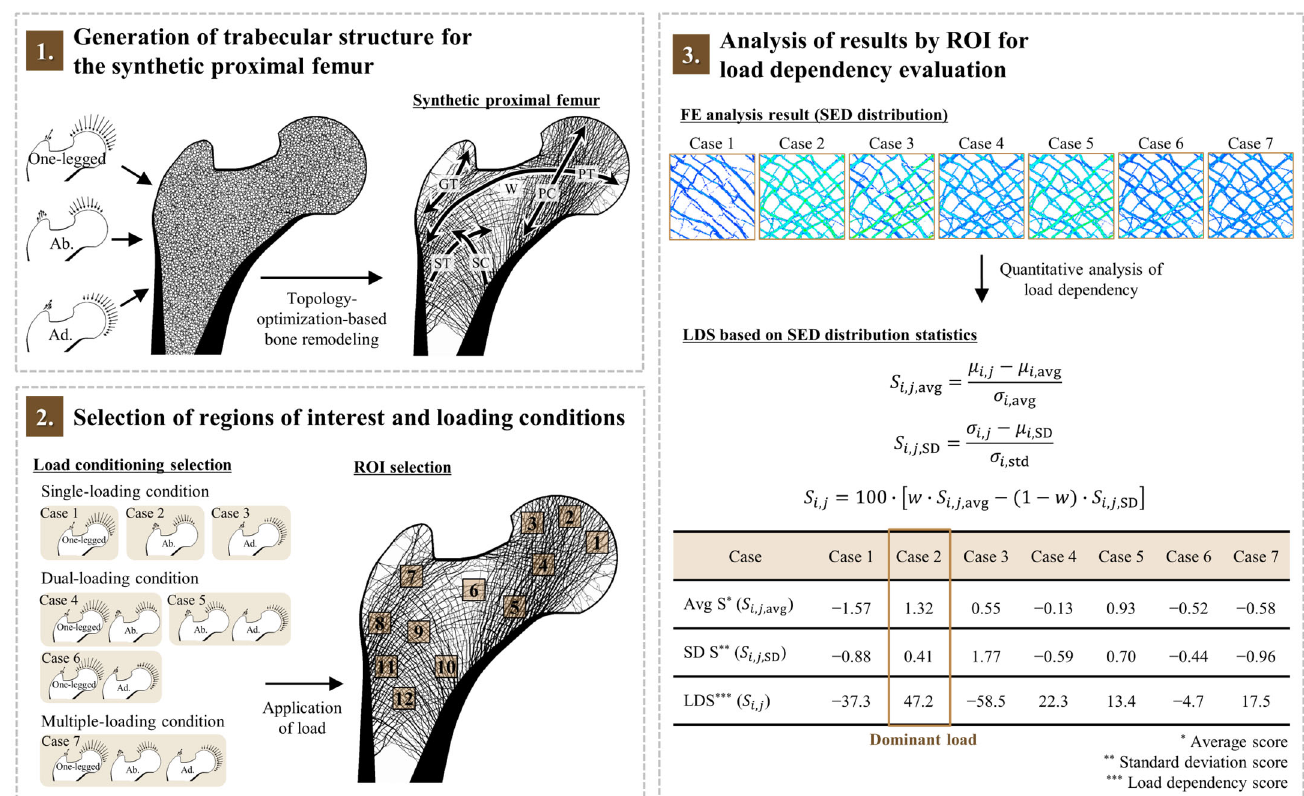
Figure 1. Overview of loading condition dependency analysis of the trabecular bone microstructure based on the ROI for different loading conditions. Ab: abduction; Ad: adduction; GT: the greater trochanter group; PC: the principal compressive group; PT: the principal tensile group; ST: the secondary tensile group; SC: the secondary compressive group; W: Ward’s triangle; ROI: region of interest; FE: finite element; SED: strain energy density; LDS: load dependency score; and S: score.